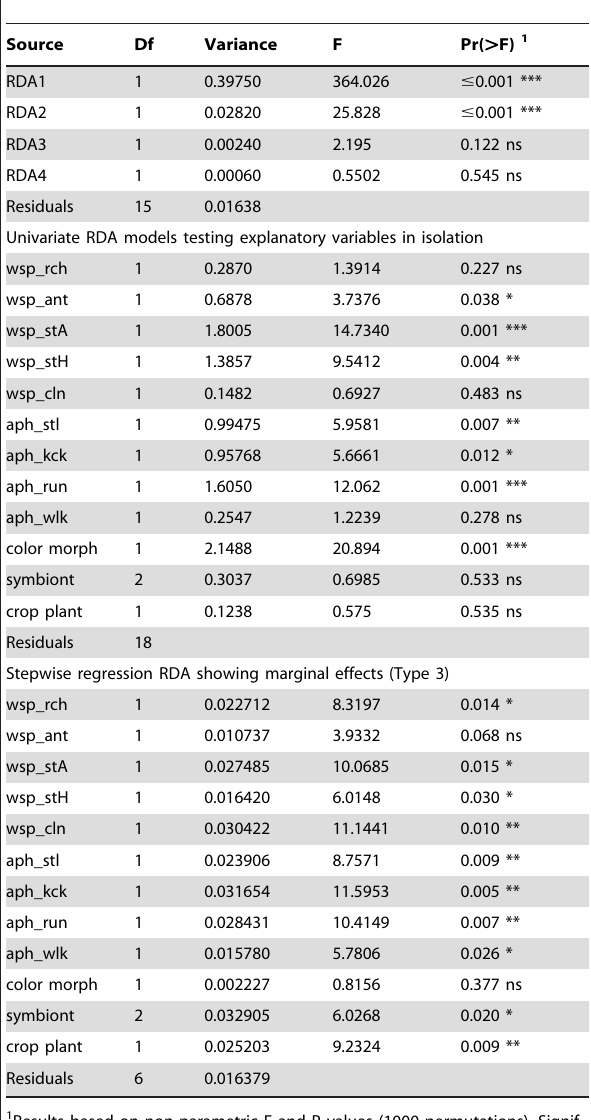
1 Results based on non-parametric F and P values (1000 permutations). Signif. codes: 0 ‘***’ 0.001 ‘**’ 0.01 ‘*’ 0.05 $ 0.05 ‘ns’ RDA axes 1 and 2 are highly significant predictors of outcomes. Note discrepancy in significance for several explanatory variables when tested in isolation vs. as marginal effects, in particular aphid color morph.